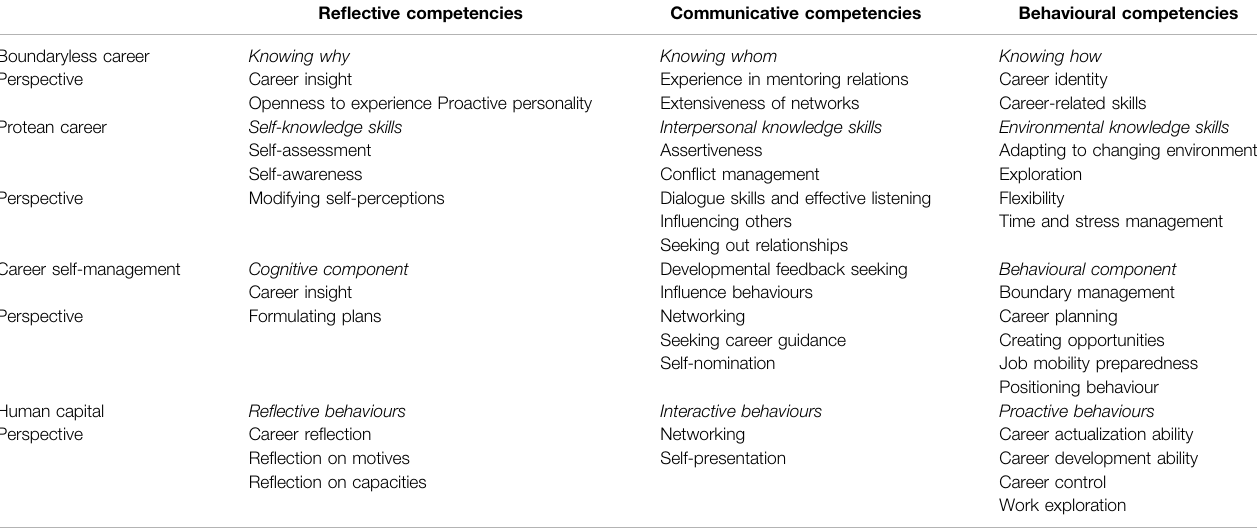
TABLE 1 | Integration of four perspectives on career competencies in three overarching categories (Akkermans et al., 2013).